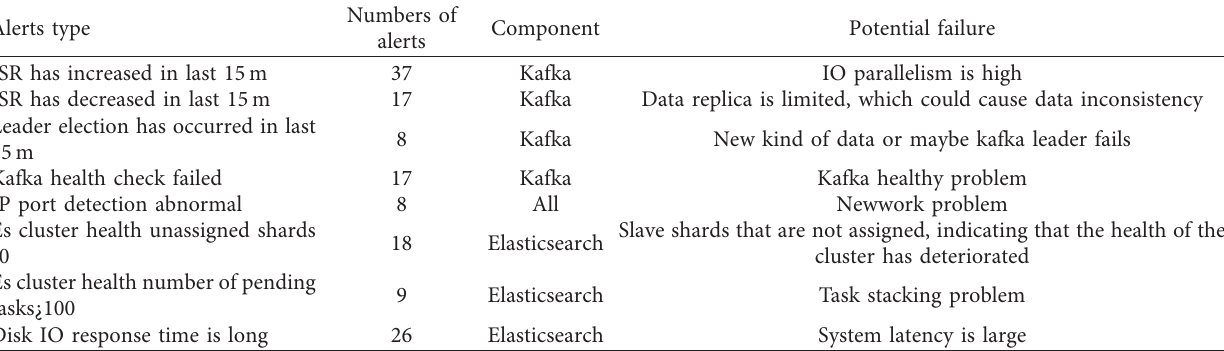
Table 1: Total types of alerts.